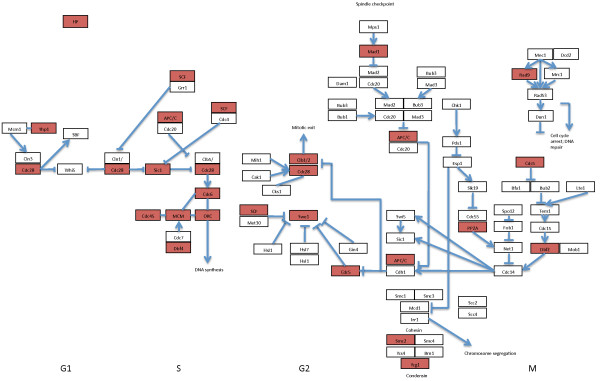
Haploproficient genes. The incidence of genes identified in genome-wide deletion library screens [8] as haploproficient within the S.cerevisiae cell cycle (haploproficient genes highlighted in red) (pathway diagram derived from the KEGG database [45]). Abbreviations: APC = anaphase promoting complex; SCF = Sck1-Cdc53/CUL-F Box receptor E3 complex; MCM = minichromosome maintenance complex; ORC = origin recognition complex; PP2A = protein phosphatase 2 complex. Haploproficient members of the complexes are listed in Additional file 2: Table S2.